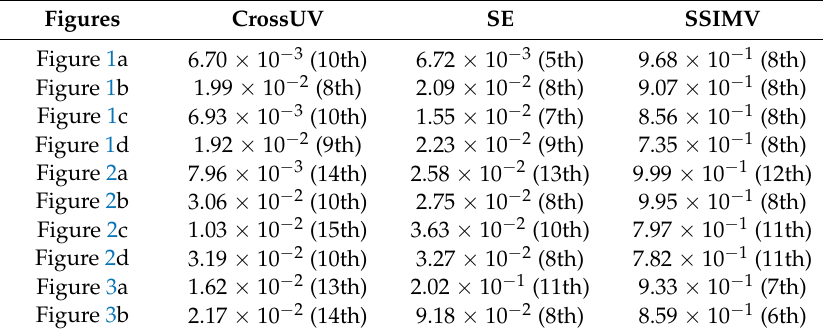
Table 1. Optimal CrossUV, SE, and SSIMV computed from simulated and experimental fringe patterns by the Fourier transform method. Figures